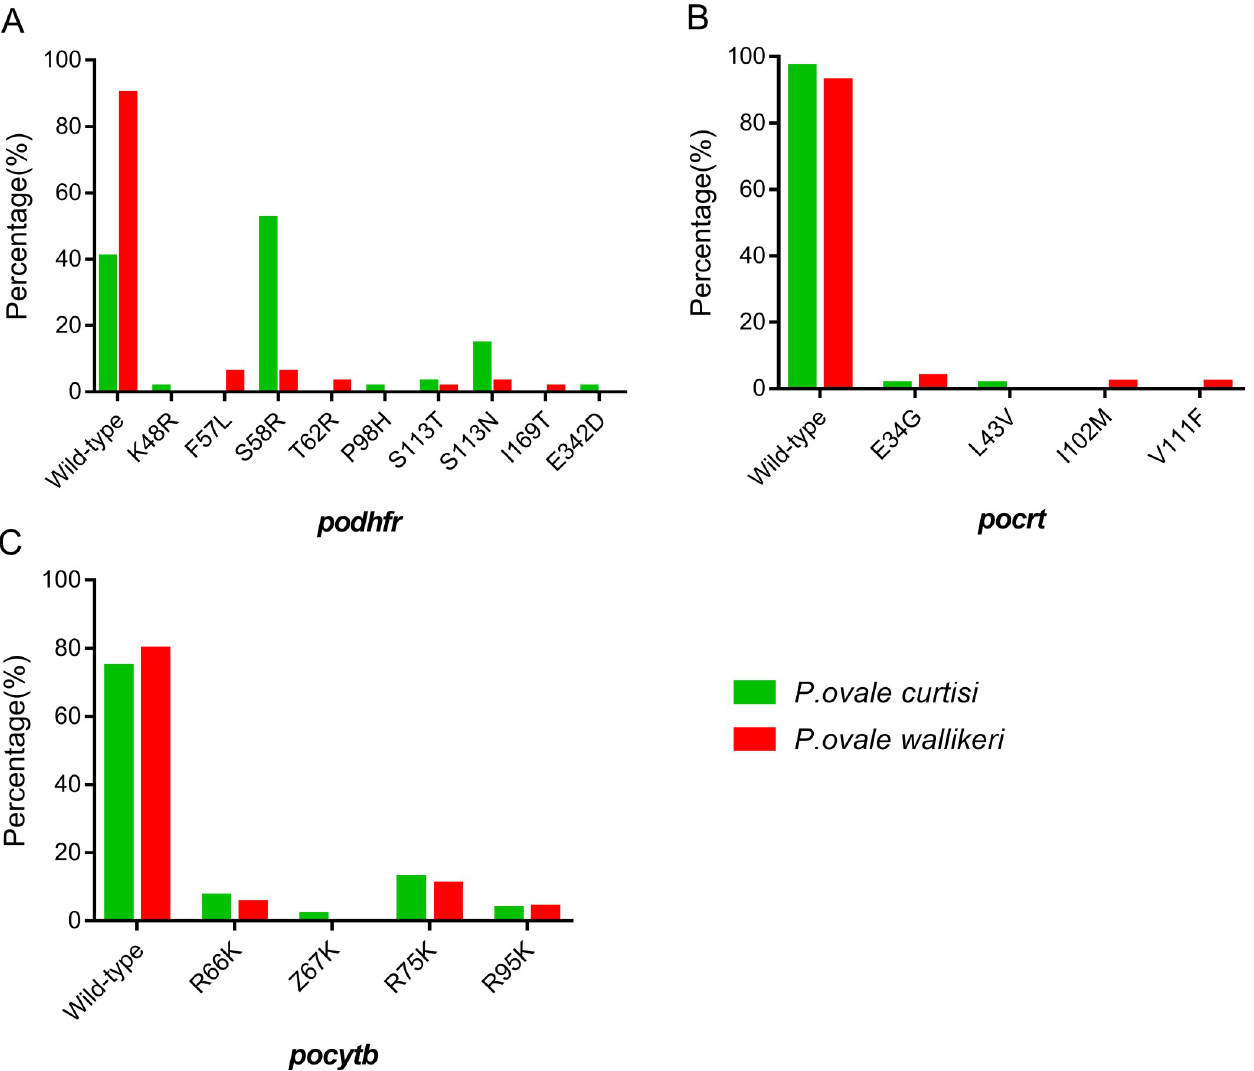
Fig 1. Mutation prevalence of podhfr , pocrt and pocytb in P . ovale curtisi and P . ovale wallikeri isolates. (A) podhfr (B) pocrt (C) pocytb . were from the Democratic Republic of the Congo, four were from the Republic of Congo and three were from Cameroon. The frequency of the S58R mutation in Central Africa (74.4%, 32/ 43) was significantly higher than West Africa (14.3%, 2/14) and Southern Africa (16.7%, 2/12). Most of the S113N mutations (8/10, 80%) in P . ovale curtisi were also from Central Africa with five samples from the Democratic Republic of the Congo and three samples from the Republic of Congo. The frequency of S113N mutation in Central Africa (18.6%, 8/43) was slightly higher than Southern Africa (16.7%, 2/12). All 10 samples of P . ovale curtisi with S113N mutations were S58R/S113N double mutants. Seven and five podhfr haplotypes were found with haplo- type diversities ( Hd ) of 0.681 and 0.192 in P . ovale curtisi and P . ovale wallikeri , respectively (Table 3). For pocrt , four mutations were found, all at low frequencies. E34G and L43V were observed in only one sample each, and only in P . ovale curtisi .E34G was observed in two samples of P .